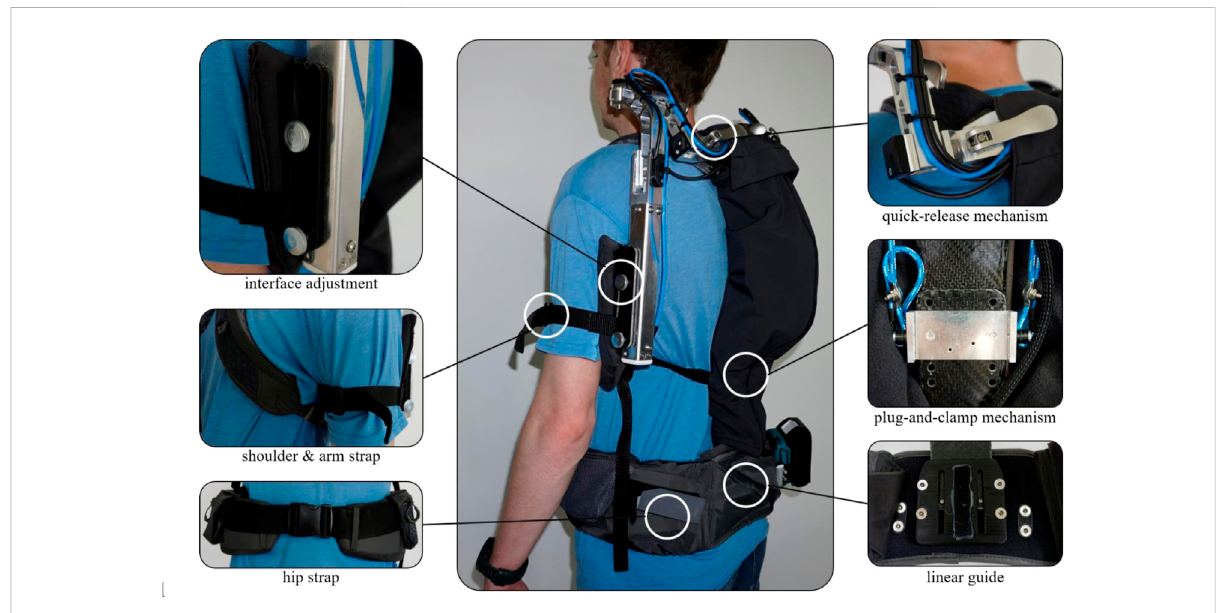
FIGURE 6 Adaptation possibilities to human anthropometry at the example of exoskeleton Lucy.